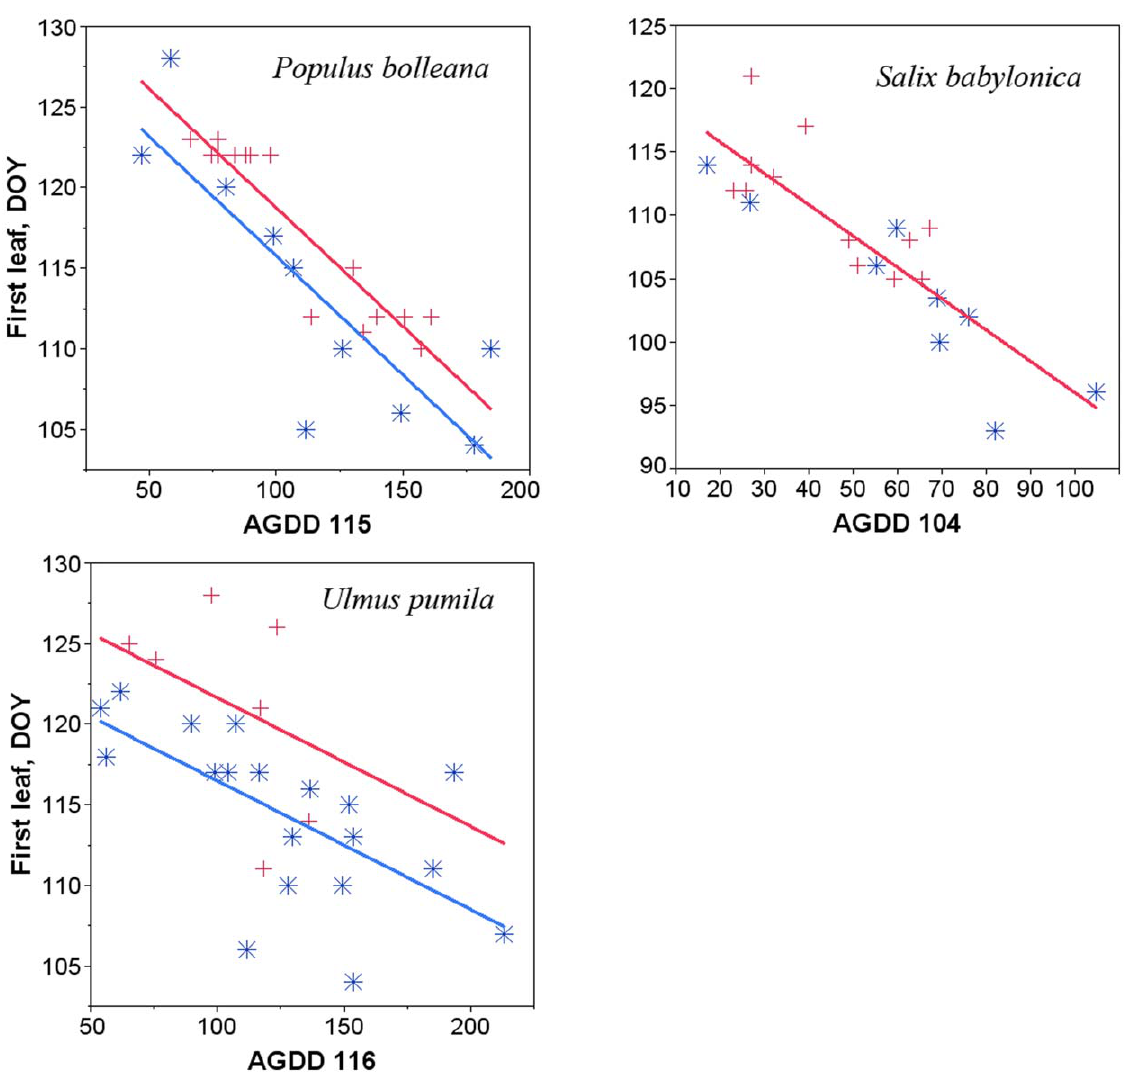
Figure 3. Graphical representation of ANCOVA analysis for the leaf emergence phenophase. Historical data are depicted by blue star symbols and spatial data by red crosses. Linear fits (either a single or two parallel lines) are selected based on ANCOVA. X axis is the growing degree days accumulated to a specified day of year.